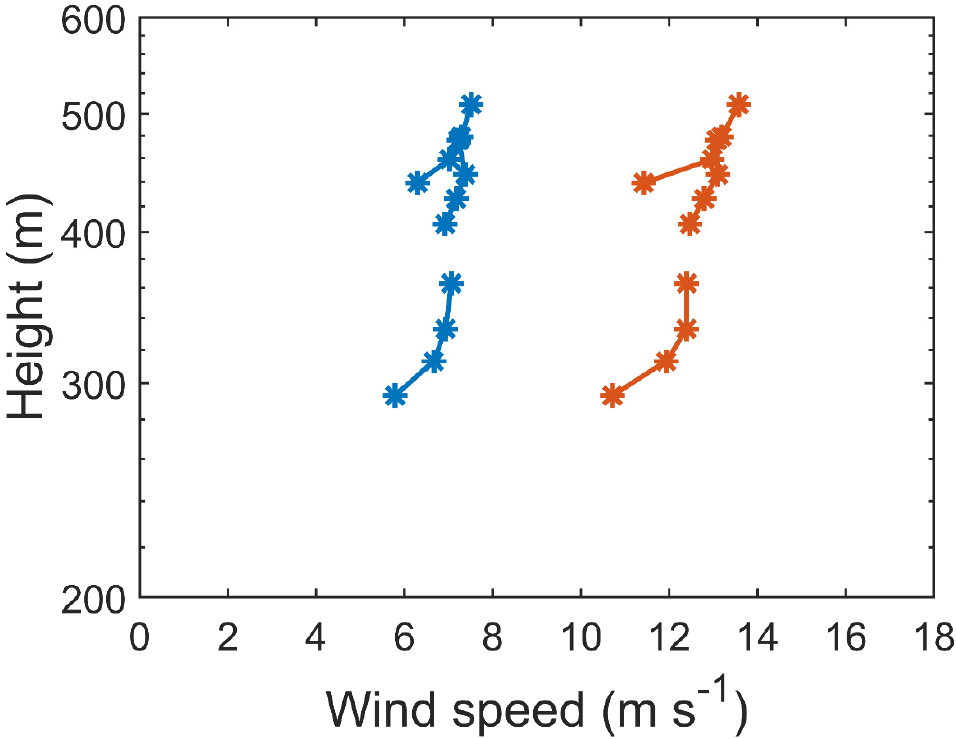
Figure 3. Vertical profiles of the mean wind speed (m s − 1 ). Blue: low-speed group with wind speed between 5 and 10 m s − 1 ; Orange: high-speed group with wind speed greater than 10 m s − 1 .